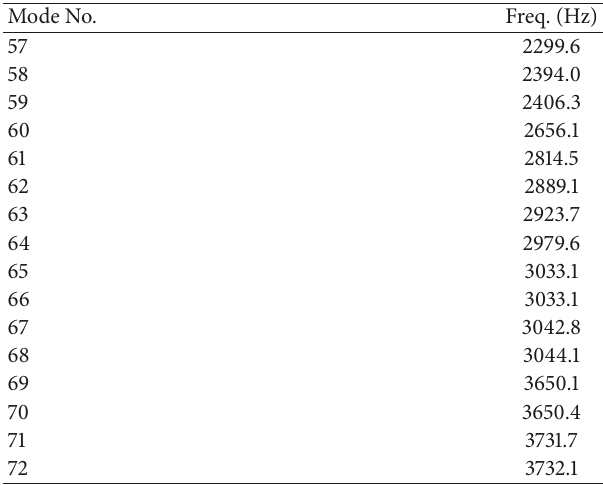
Table 3: Natural frequencies of the two-stage planetary gear rotor